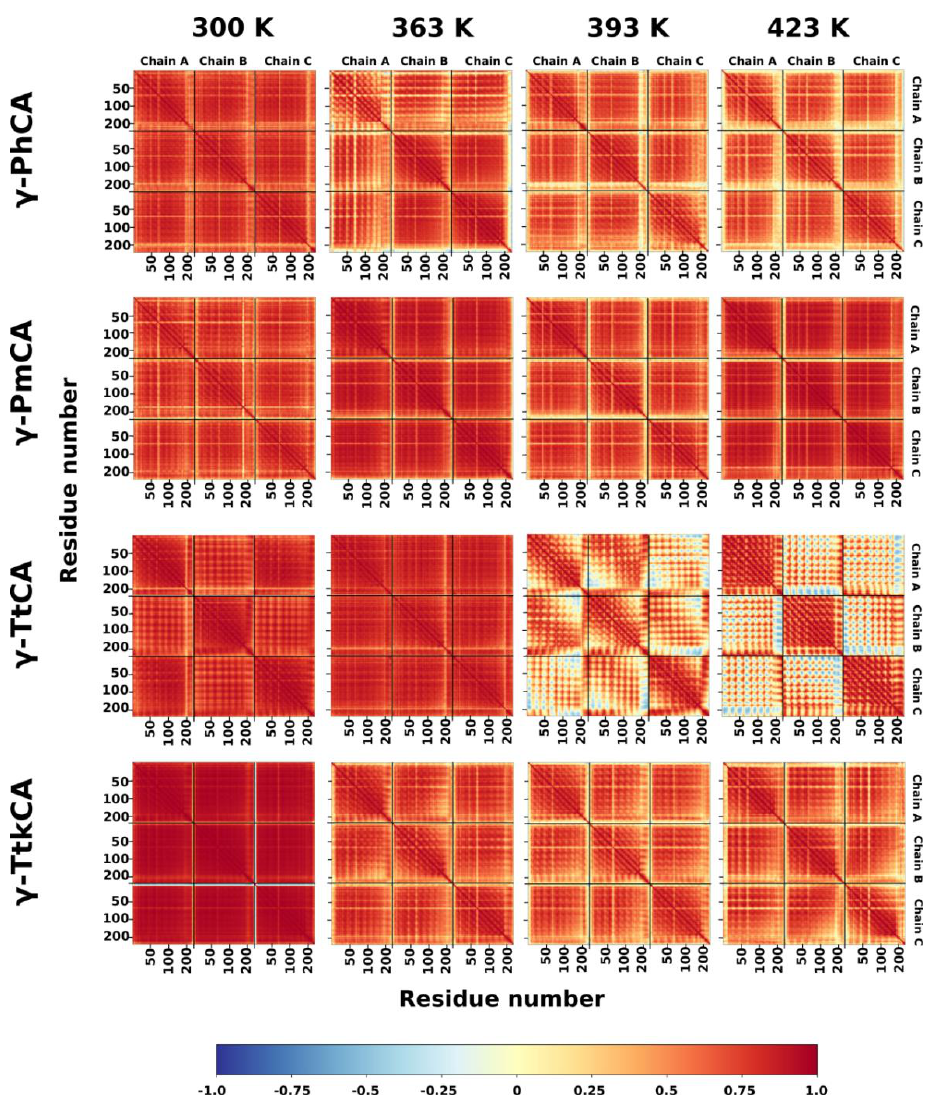
Figure 8. Dynamic cross correlation (DCC) heat maps for γ - PhCA, γ - PmCA, γ -TtCA, and γ -TtkCA at 300 K, 363 K, 393 K, and 423 K.